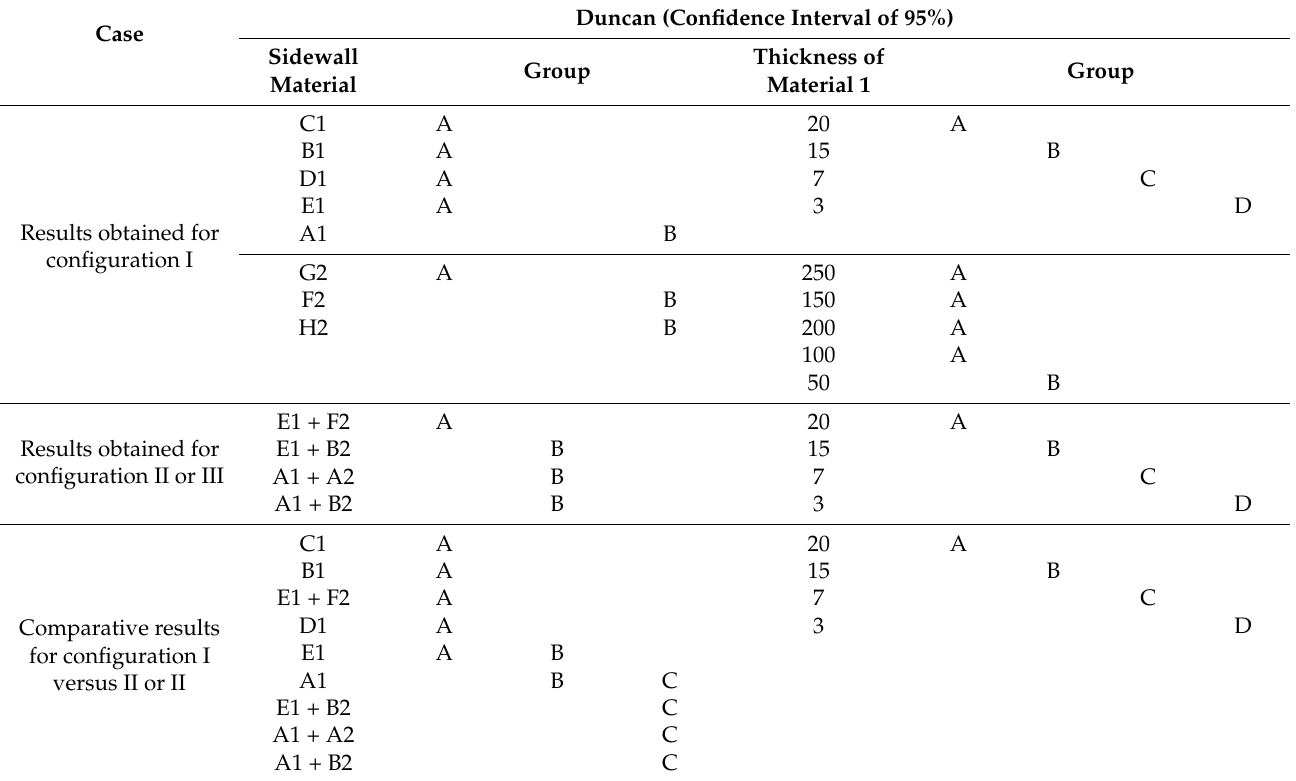
Table 12. Duncan’s test for heating time using different sidewall configurations, materials, and material thicknesses.